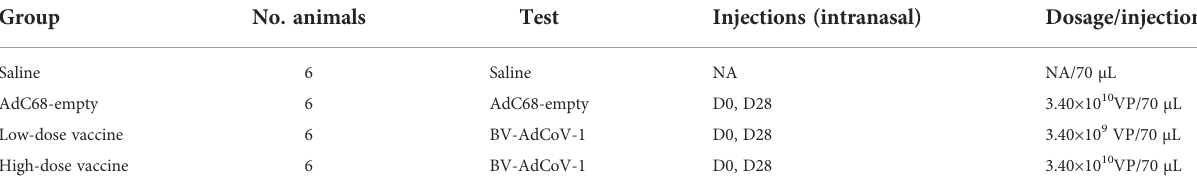
TABLE 2 Grouping of golden Syrian hamsters and vaccine dose. Group